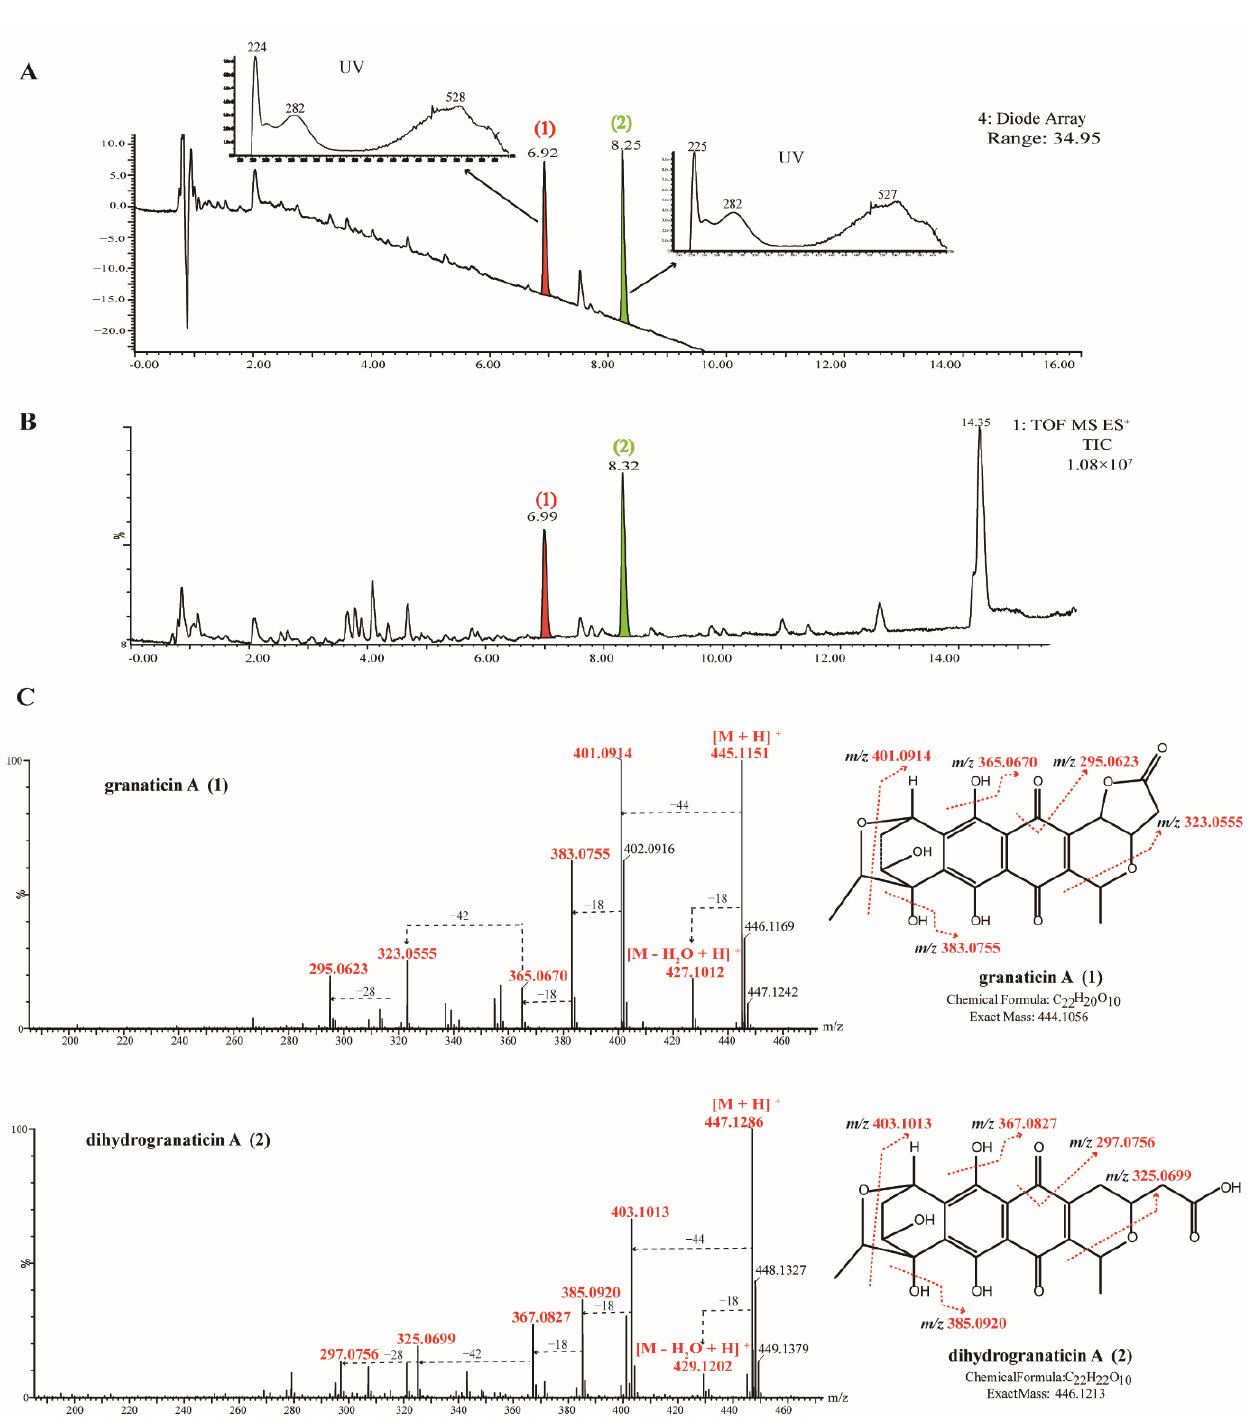
with granaticin A [43,46].